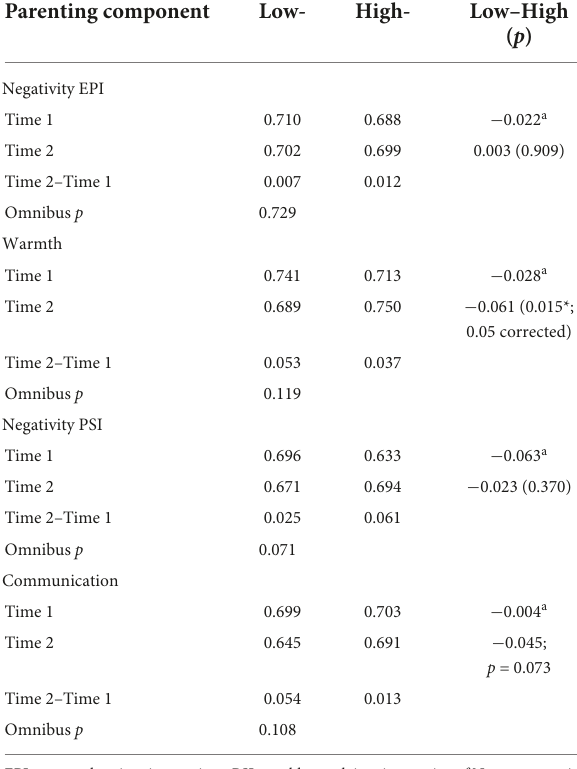
TABLE 5 Modularity (participation coefficient) and group differences for low- and high-parenting components, time 1 and 2 ( n = 114). Parenting component Low- High- Low–High